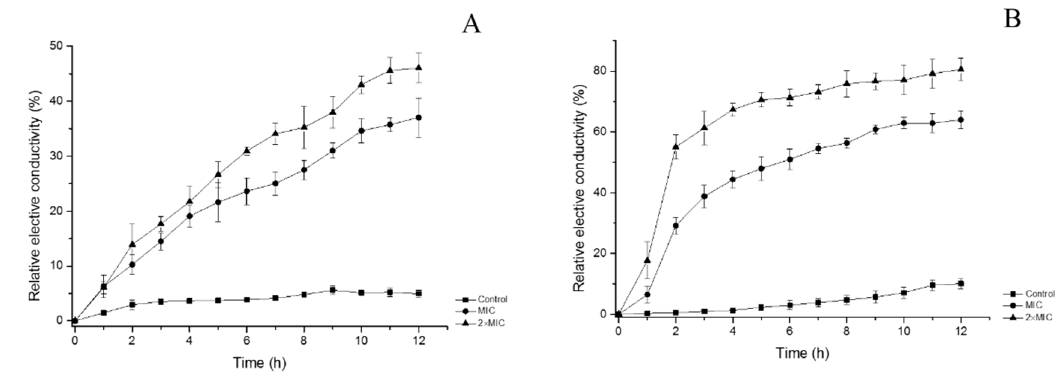
Figure 3. Effects of FCEO on the permeability of E. coli and S. aureus . A : E. coli ; B : S. aureus .